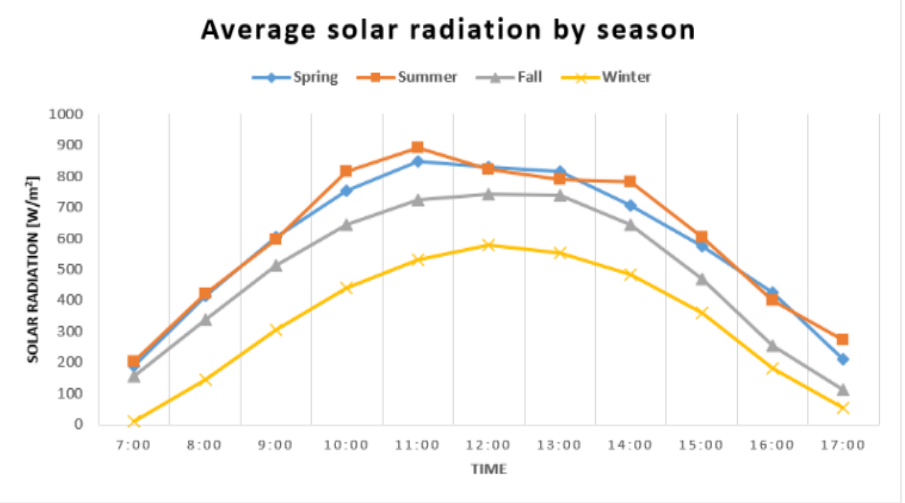
Figure 5. Characteristics of season-basis solar radiation.